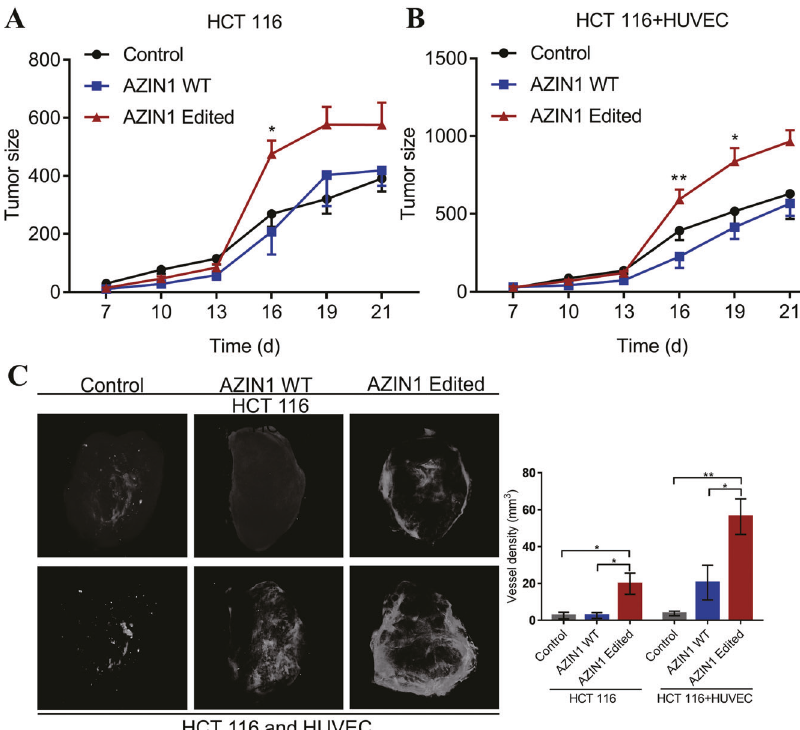
Fig. 3 Effects of promoting tumor angiogenesis of edited AZIN1 in vivo. A HCT 116 cells were used in the xenograft model. B The mixture of HCT 116 and HUVEC cells were used in the xenograft model. Tumor sizes measured by caliper every 3 days in vivo model. C Representative images of intratumoral vessels by micro-CT. The vascular network was reconstructed using the CTAn software. Data are presented as means ± SEM. Data in A and B were analyzed with two-way ANOVA test with a Dunnett ’ s post hoc test. One-way ANOVA with Tukey ’ s test as post-hoc test was used to assess the difference of data in C . * P < 0.05, ** P < 0.01, *** P <